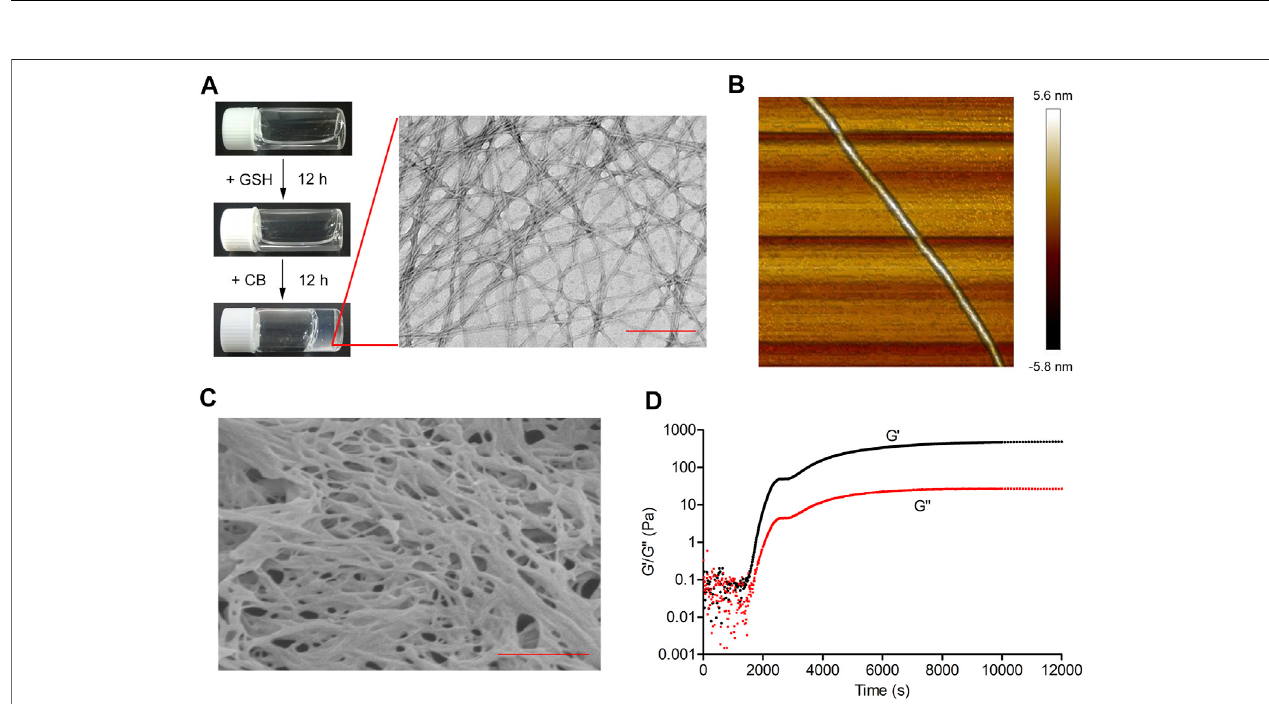
FIGURE 2 | The self-assembly property of cyclic-1a. (A) Schematic illustration of the conversion of cyclic-1a into linear-1a by GSH and then of linear-1a into linear- 1b by CB. Optical images of a solution of cyclic-1a (1,600 μ M), a solution of cyclic-1a formed by adding GSH (8 mM) to a solution of linear-1a, and a gel of linear-1a formedbyaddingCB(1U/mL)toasolutionoflinear-1b.TEMimagesoflinear-1b(Scalebar (cid:1) 200 nm). (B) AFM3D-imageofasinglenano fi ber. (C) SEMimageofcritical point dried hydrogel (Scale bar (cid:1) 500 nm). (D) Oscillatory rheology of the cyclic-1a solution after the addition of both GSH and CB. inside cells; (ii) a self-assembly process of intracellular nano fi bers is triggered by intracellular stimuli; and (iii) the